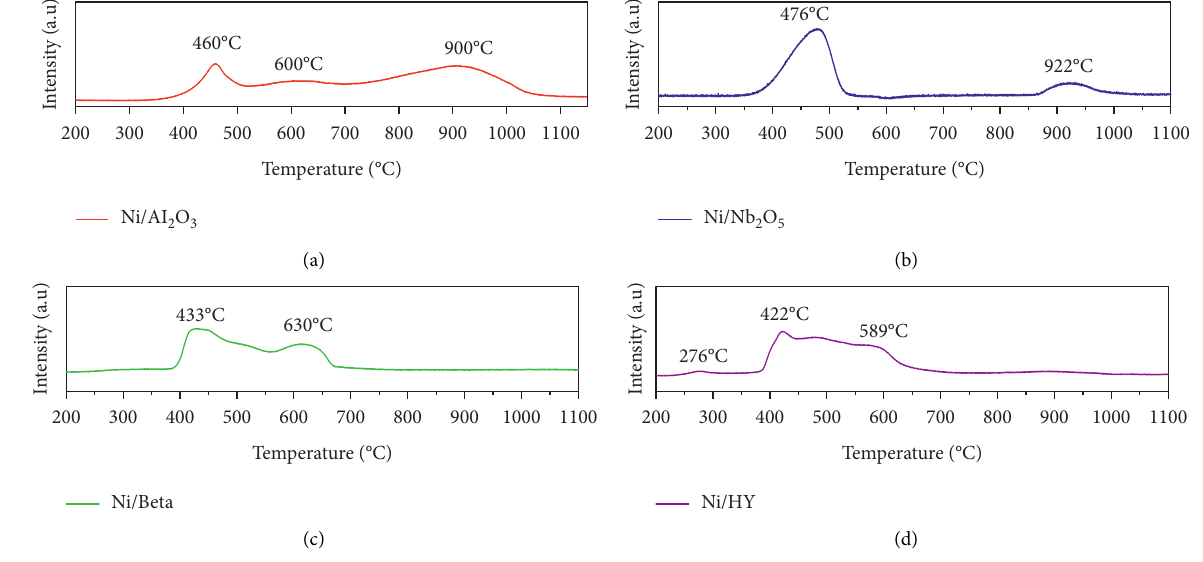
Figure 5: TPR profile of the Ni/Al